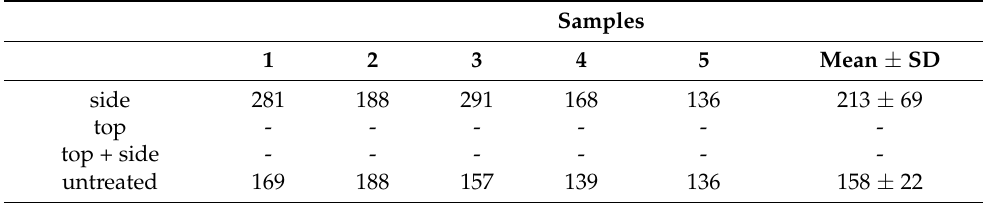
Table 1. Ignition time of the tested samples